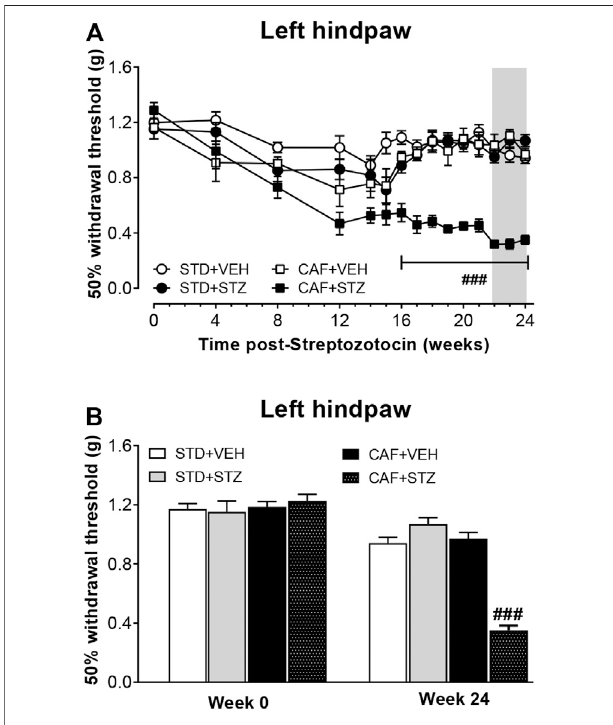
FIGURE 3 | Development of mechanical skin hypersensitivity in female mice with T2DM. (A) is showing the time course of the development of hindpaw mechanical hypersensitivity. (B) is showing the 50% withdrawal threshold values before STZ injection and 24 weeks-post STZ, respectively. Values are mean ± SEM (n (cid:1) 10). In (A) , ### p < 0.001 for the interaction CAF × STZ [F (1, 36) (cid:1) 42.4]. In (B) ### p < 0.001 for the interaction CAF × STZ [F (1, 36) (cid:1) 86.6]. Data in (A) were analyzed by Repeated-Measures Three-Way ANOVA followed by Bonferroni multiple comparison. Data in (B) were analyzed by Two-Way ANOVA. STD: Standard diet; CAF: Cafeteria diet; VEH: vehicle; STZ: streptozotocin. The gray rectangle is indicating the period in which the analgesic drugs were